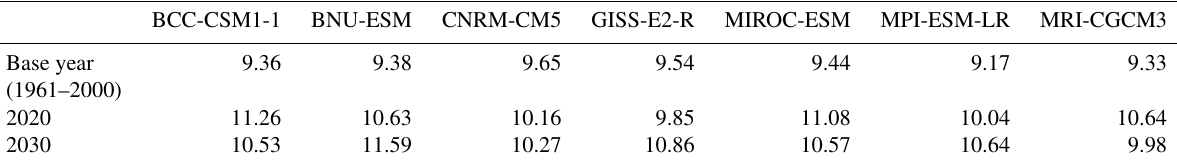
Table 1. Daily average temperature projected by different GCMs in the Haihe River basin.